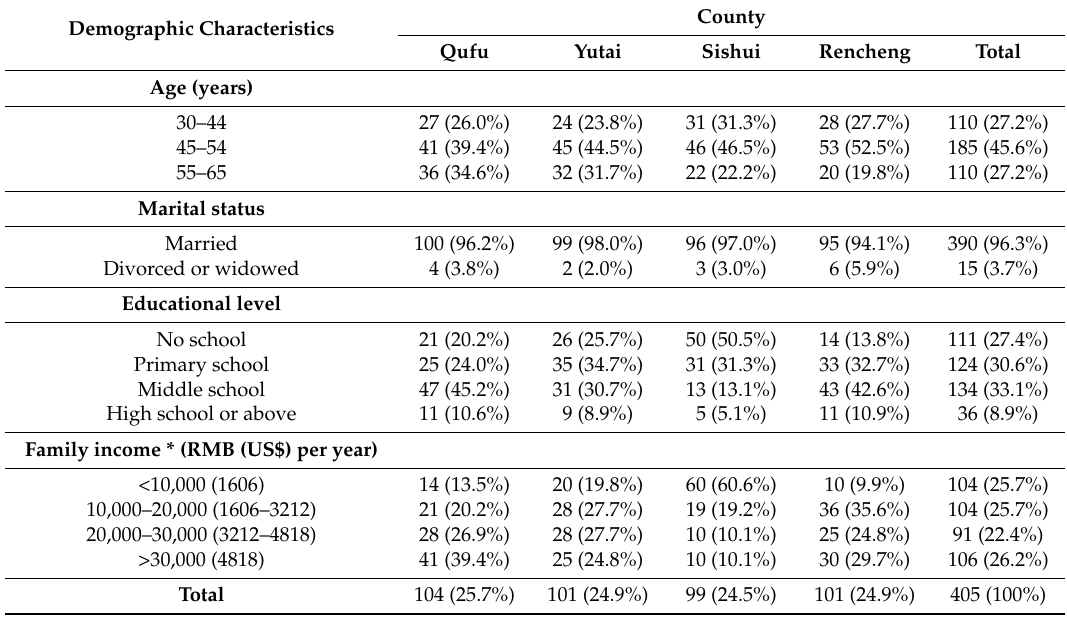
Table 1. Socio-demographic characteristics of the participants in the four counties, n (%).